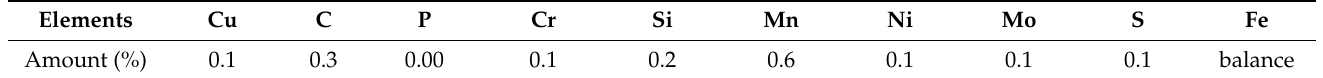
Table 5. Elemental composition of the reinforcing steel used.